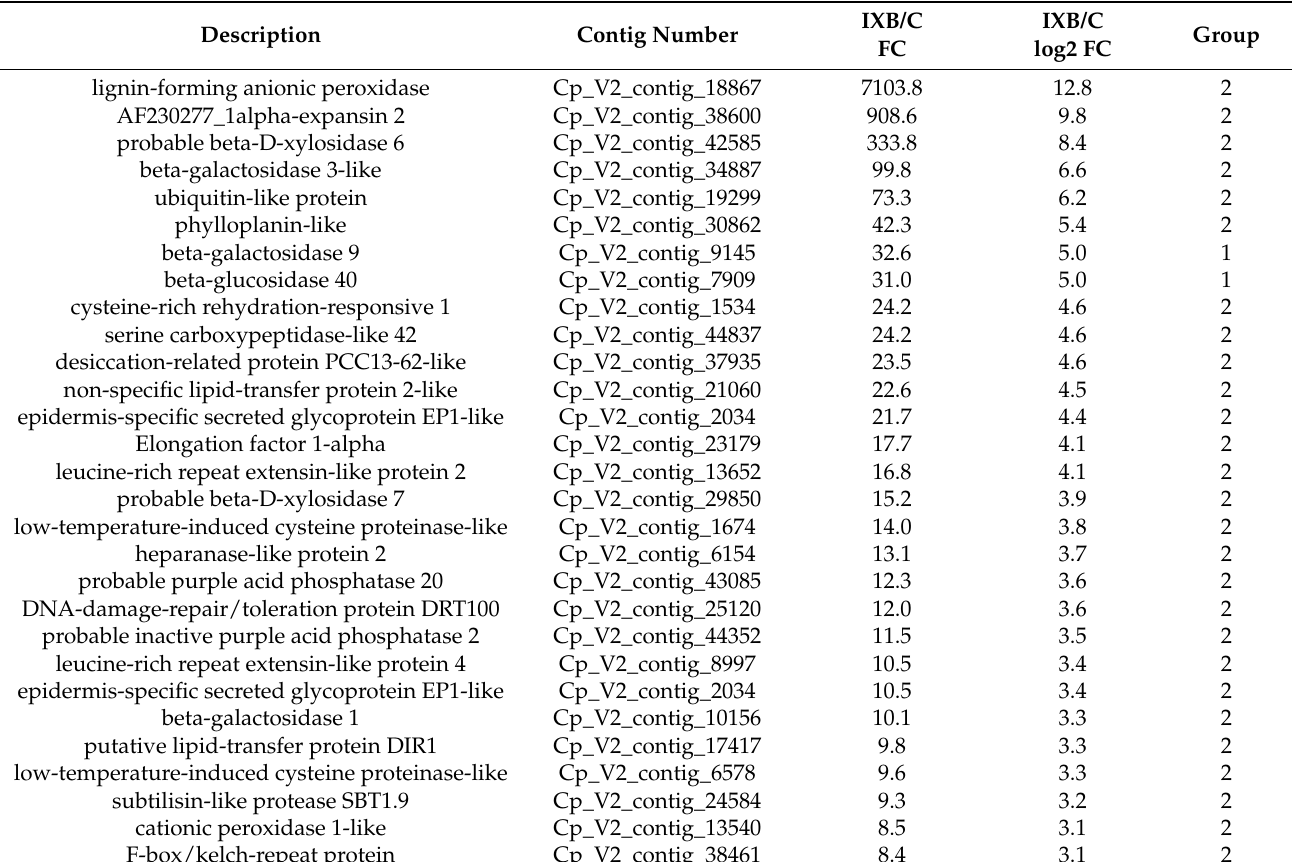
Table 2. Excerpt of Supplementary File S1 showing proteins with higher abundance in IXB-habituated cells compared to the C. The fold change (FC ≥ 8) and log2 FC ≥ 3, as well as the contig numbers, the group classification according to the HC are